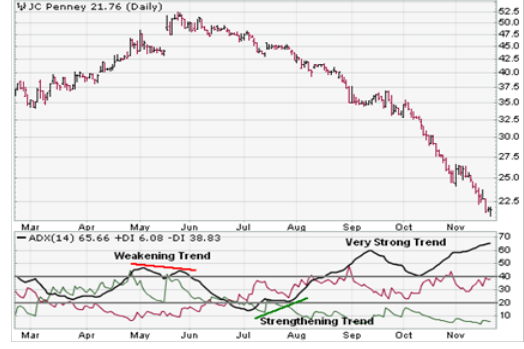
Fig. 4. Average Directional Index chart The ADX is calculated from the Positive Directional Indicator (+DI) and the Negative Directional Indicator (-DI) as shown in (5. ADX is the thick black line with less fluctuation, +DI is green and -DI is red as shown in Fig. 4. +DI indicates the strength of the up moves and - DI indicates the strength of the down moves over a given period. The ADX combines +DI with -DI,